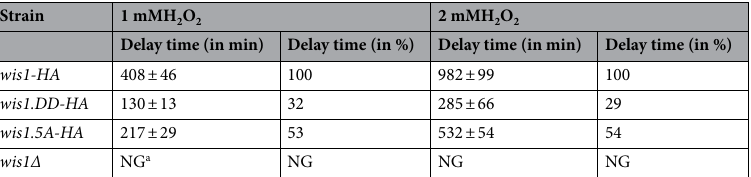
Table 1. The delay time of untreated and H 2 O 2 –treated growth curves, determined at an apparent OD 600 of 0.5, is shown in minutes (min) and percentage (%). Standard deviation from biological triplicates is indicated. a No growth detected for H 2 O 2 –treated